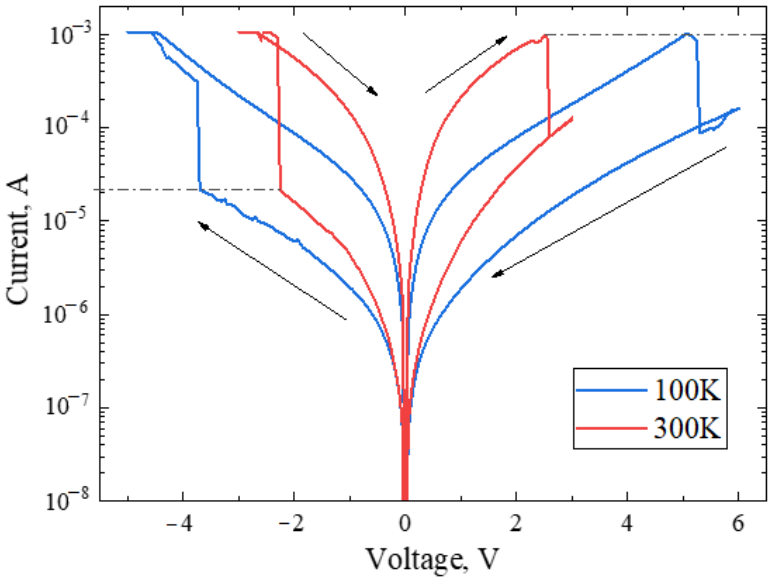
Figure 12. I–V curves the sample C12A7:e − at the temperatures of 100 K ( blue ) and 300 K ( red